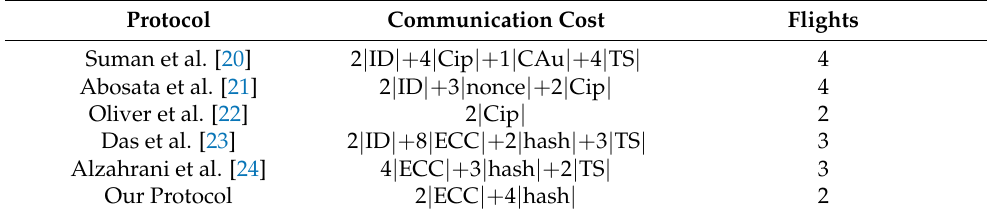
Table 7. Comparison of Communication overhead with similar schemes.